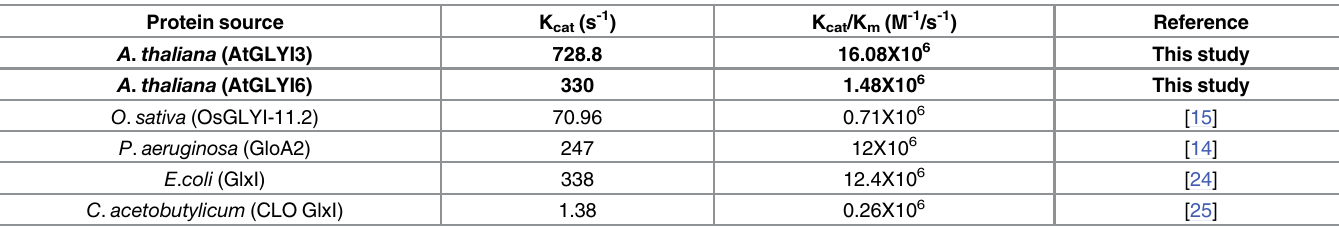
Table 4. A comparison of the kinetic parameters of AtGLYI3 and AtGLYI6 (Ni 2+ dependent GLYI) with Ni 2+ dependent GLYI from other species. Protein